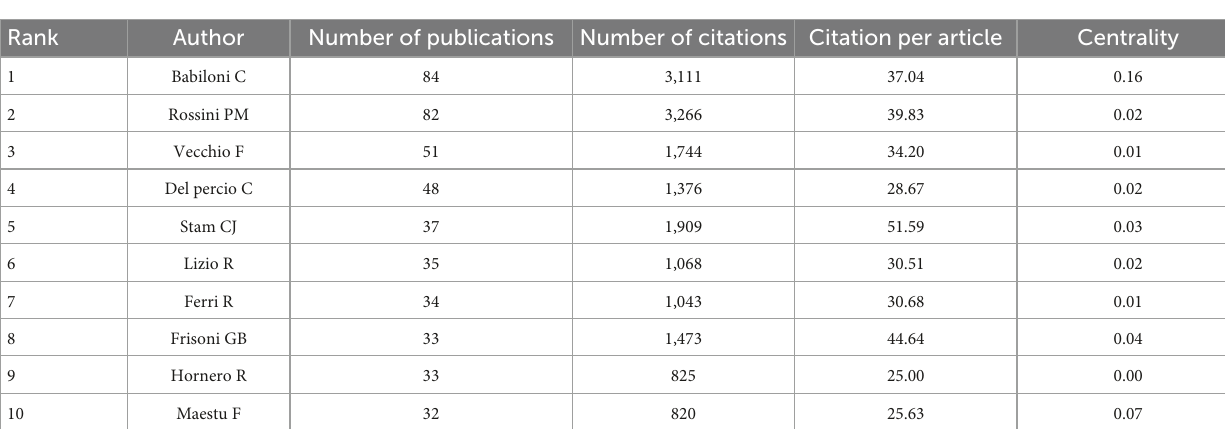
TABLE 4 Top 10 productive authors from 2005 to